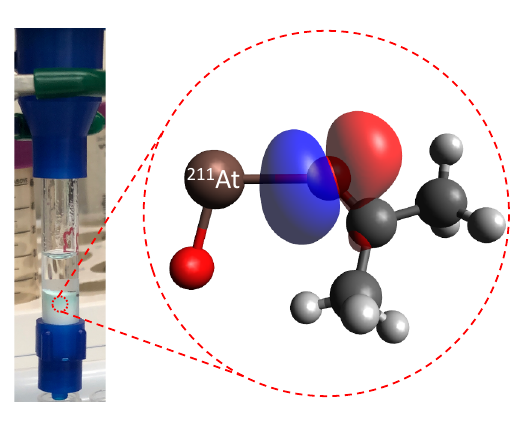
Figure 6. Left: Photo of 211 At purification column. Right: De- piction of DFT calculation demonstrating how At-211 interacts with a ketone.